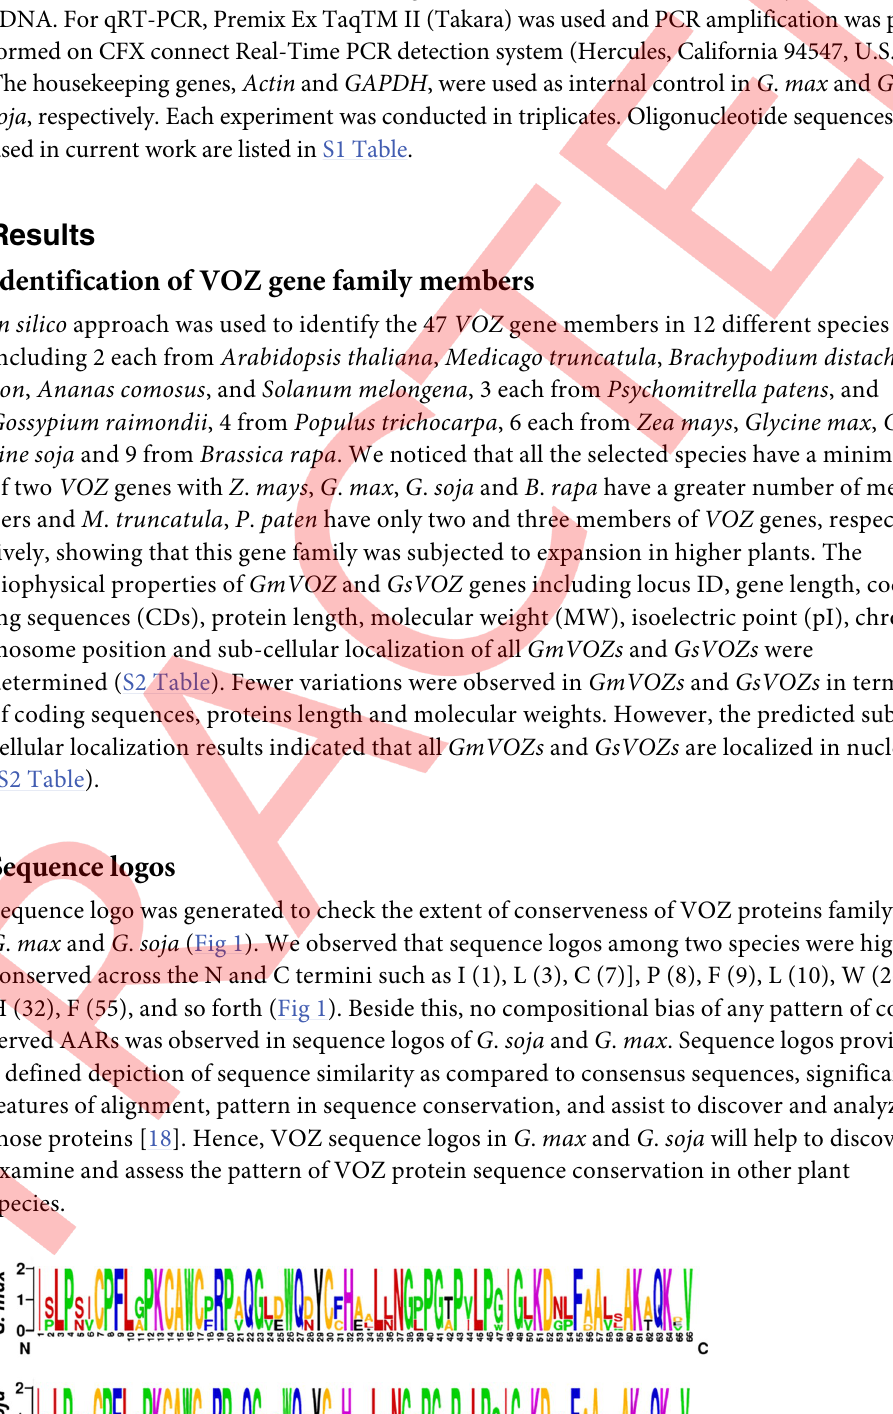
Fig 1. Vascular plant one-zinc-finger sequence logo of G . max and G . soja . Amino acid pattern depicts that they are highly